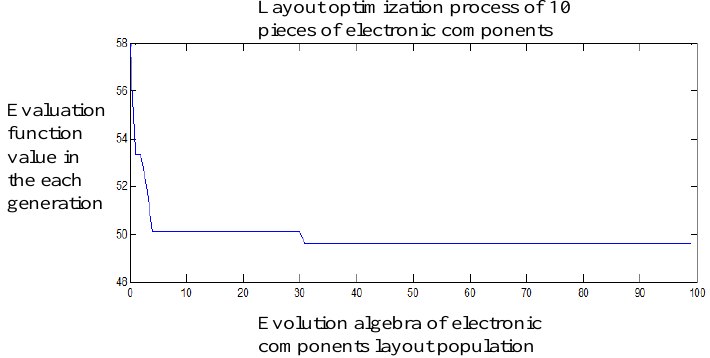
Figure 9. The dynamic process of electronic component layout optimization.